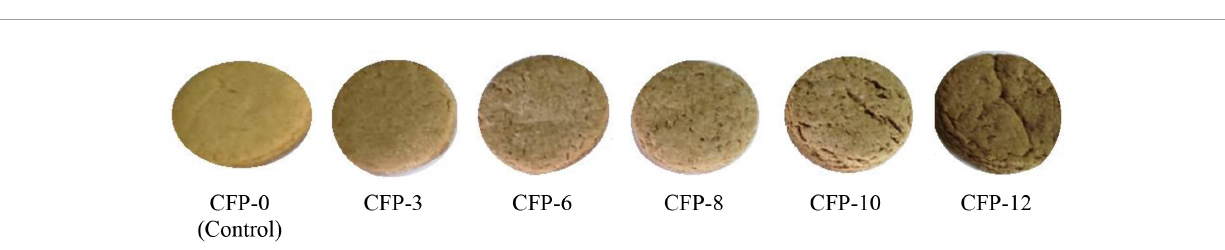
FIGURE3 Pictures of cookies. CFP-0 = Cookies fortified with 0 g PP powder (control), CFP-3 = Cookies fortified with 3 g PP powder, CFP-6 = Cookies fortified with 6 g PP powder, CFP-8 = Cookies fortified with 8 g PP powder, CFP-10 = Cookies fortified with 10 g PP powder, CFP-12 = Cookies fortified with 12 g PP